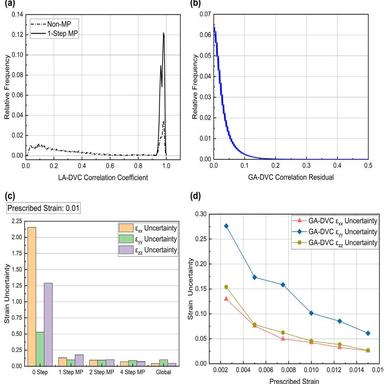
(a) Comparison between non-multi-pass (MP) and 1-step multi-pass CLA-DVC for the 0.01 virtual strain; (b) RGA-DVC for 0.01 virtual strain; (c) the influence of the multipass approach on the strain uncertainty for the 0.01 virtual strain (note: global DVC results initiated with 1-step and 4-step multi-pass local DVC were virtually identical and are thus presented as a single dataset); (d) strain uncertainty as a function of prescribed strain for the global DVC.